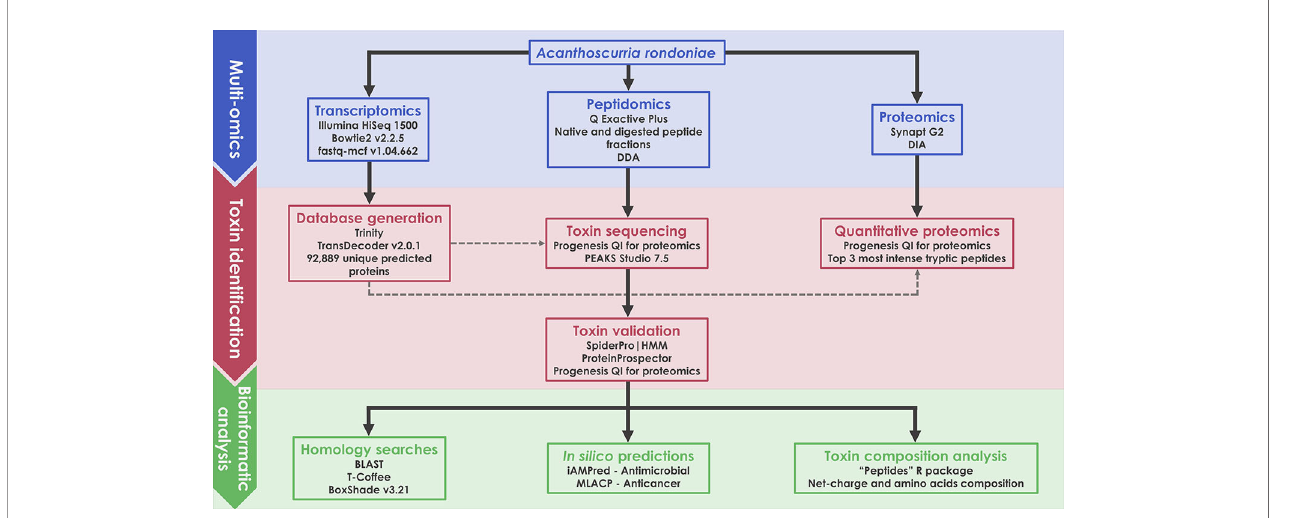
FIGURE 1 | Schematic representation of the multiomics work fl ow applied in this